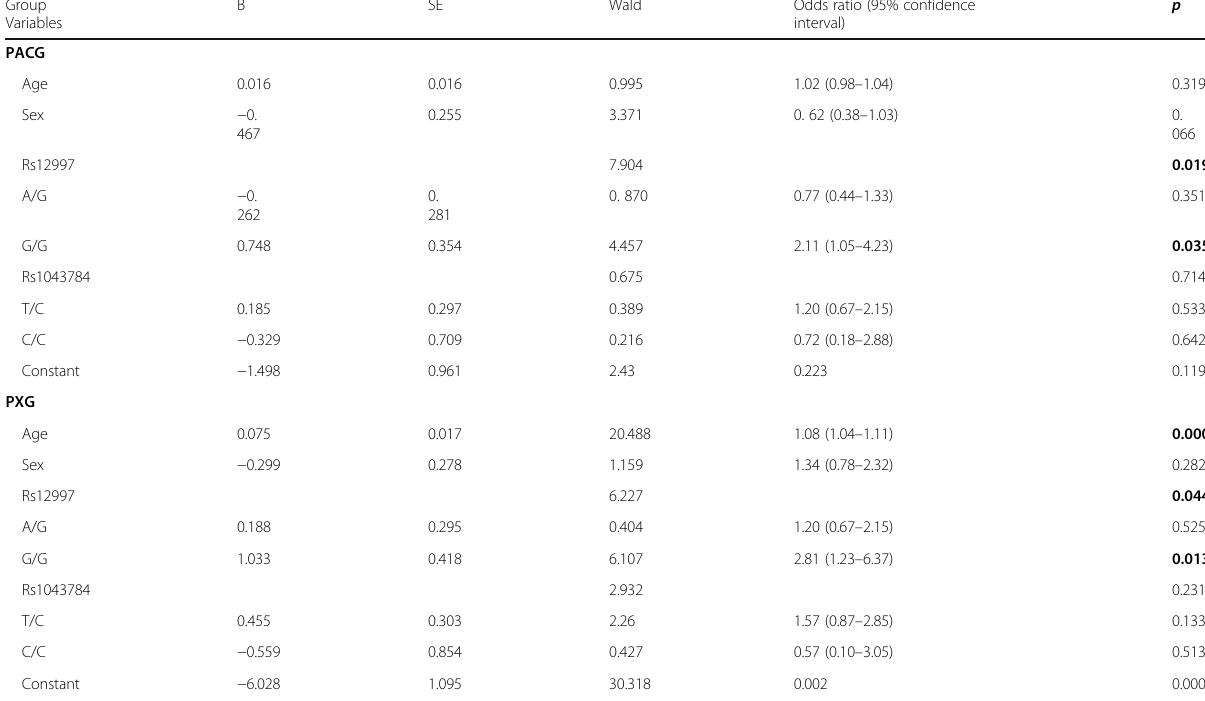
Table 6 Regression analysis to determine the effect age, sex and polymorphisms on glaucoma